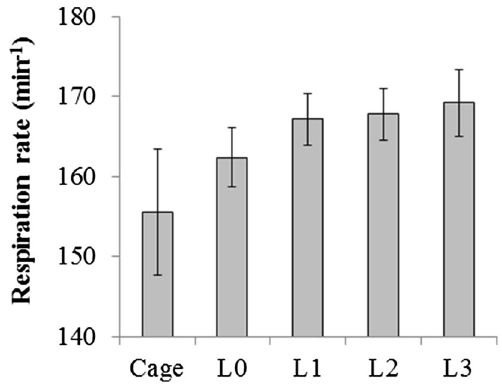
Figure 5. Breathing rate of mice in the cage or while fixed on the treadmill at exercise levels L0 to L3 (cage, n = 13; L0, n = 14; L1, n = 14; L2, n = 12; L3, n = 13). Breathing rate was weakly correlated with the exercise level (p = 0.26). L0: rest, L1: exercise level 1 (5 m/min), L2: exercise level 2 (10 m/min), L3: exercise level 3 (15 m/